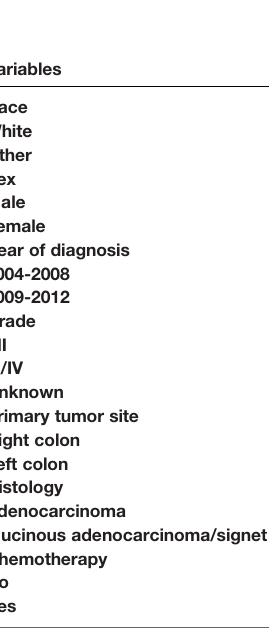
TABLE 4 | Multivariate Cox regression analyses for survival in stage III colon cancer. Variables